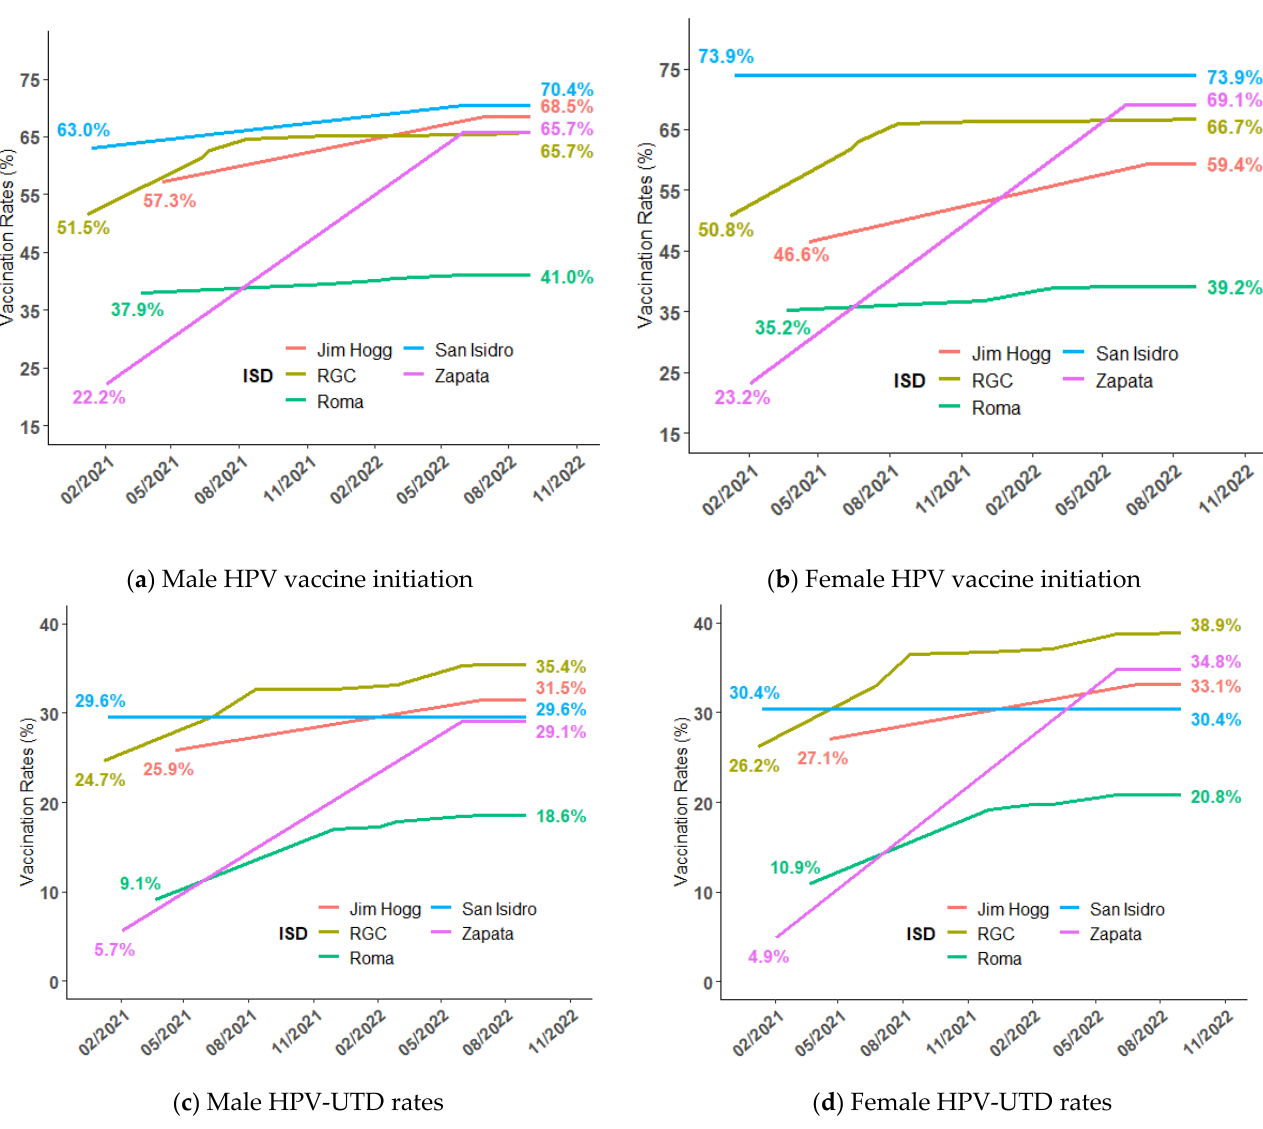
Figure 2. Male and female HPV vaccine initiations and HPV-UTD in RGCCISD, Roma ISD, San Isidro ISD, Zapata ISD, and Jim Hogg ISD: ( a ) Male HPV vaccine initiation in RGCCISD, Roma ISD, San Isidro ISD, Zapata ISD, and Jim Hogg ISD; ( b ) female HPV vaccine initiation in RGCCISD, Roma ISD, San Isidro ISD, Zapata ISD, and Jim Hogg ISD; ( c ) female HPV vaccine completion in RGCCISD, Roma ISD, San Isidro ISD, Zapata ISD, and Jim Hogg ISD; and ( d ) female HPV-UTD in RGCCISD, Roma ISD, San Isidro ISD, Zapata ISD, and Jim Hogg ISD.